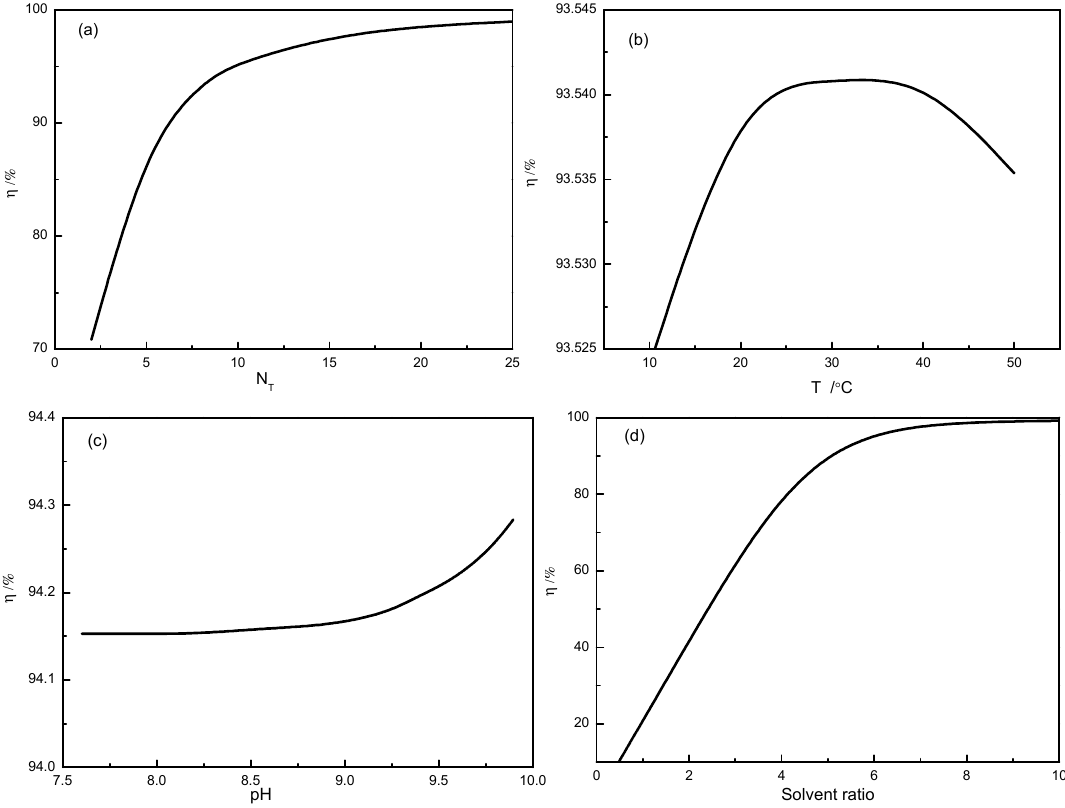
Figure 2. Effects of ( a ) number of theoretical plates (N T ), ( b ) extraction temperature (T), ( c ) pH value, and ( d ) solvent ratio on the extraction efficiency in the simulation process.